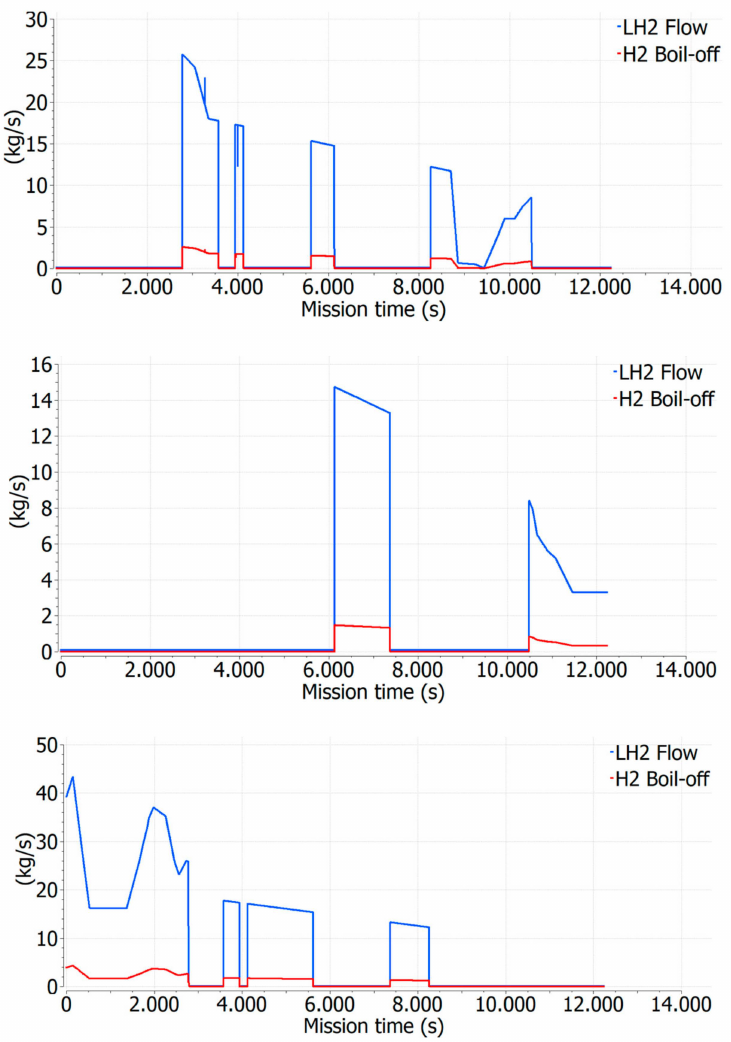
Figure 10. Propellant (blue) and boil-off (red) flows to feed TMS modules (module 1 to module